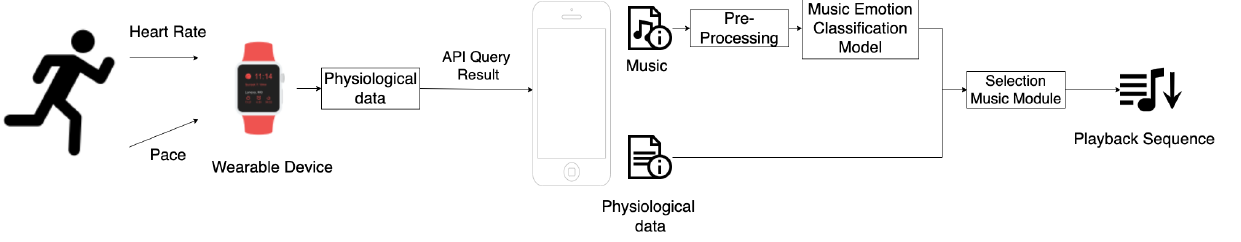
Figure 1. Overview of the proposed playback algorithm. The wearable devices pass the measured signals to smartphone. The smartphone integrates the signals, music elements, and emotion classifier into the algorithm to provide suitable playback mode for individual.